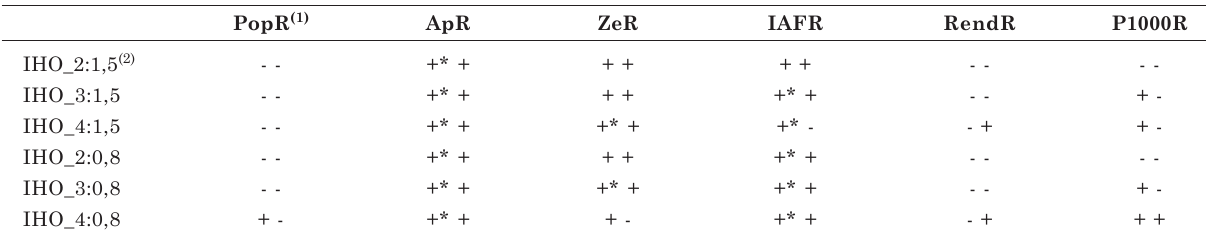
Quadro 2. Matriz de sinais (+ e -) da correlação de Spearman das medidas de plantas nos oito cultivos com o intervalo hídrico da profundidade de 0,07 m (sinais da esquerda) e 0,25 m (sinais da